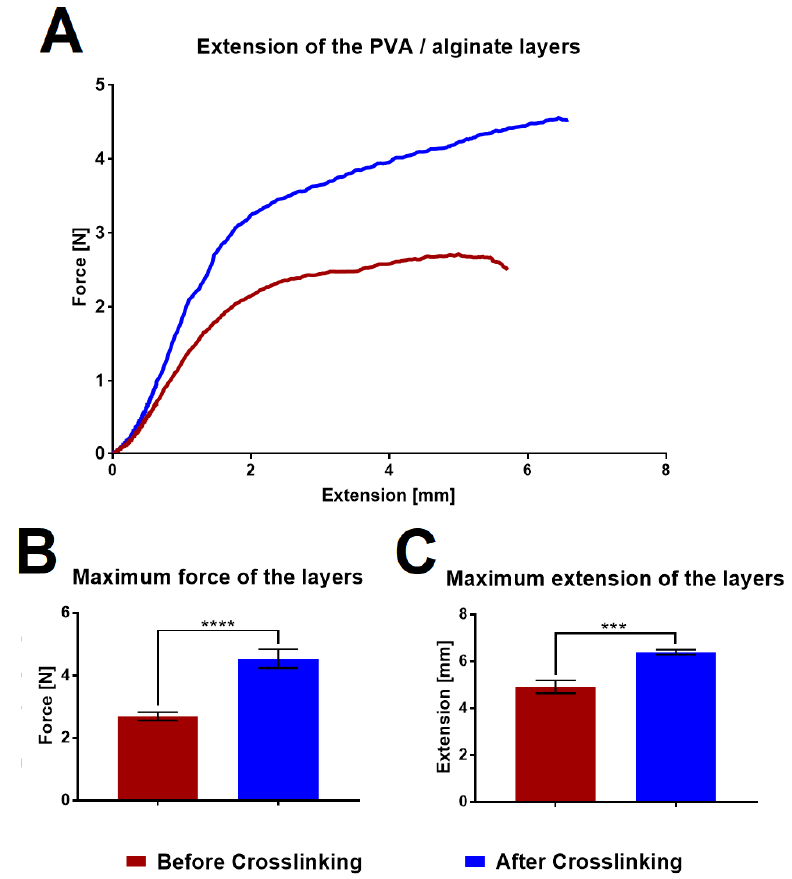
Figure 6. Mechanical testing of the PVA/alginate layers. ( A ) Results of the tensile testing of the layers before (burgundy color) and after (blue color) crosslinking. ( B ) Maximum layer strength before and after crosslinking. ( C ) Maximum elongation of the layers before and after crosslinking. 95% confidence interval (CI); *** p < 0.0006, **** p < 0.0001.